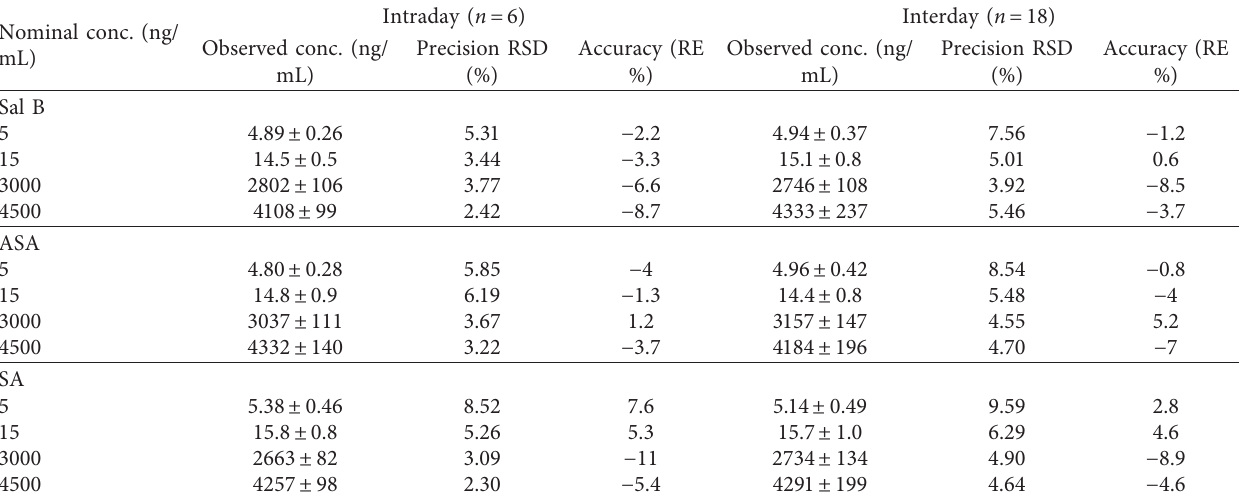
Table 4: Accuracy and precision of Sal B, ASA, and SA.